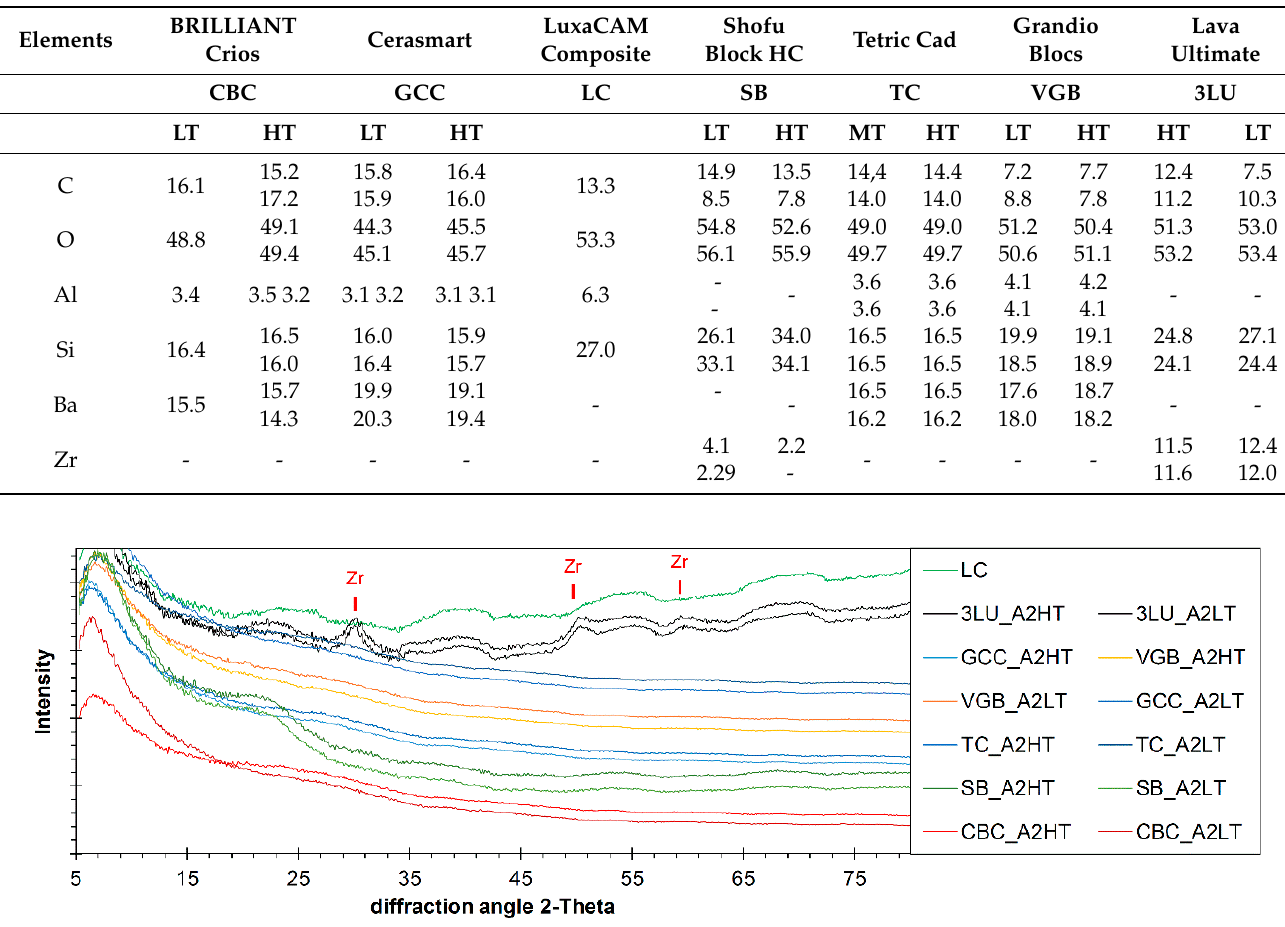
Table 6. Overview of characteristic parameters (top: manufacture data; bottom: own measured values).